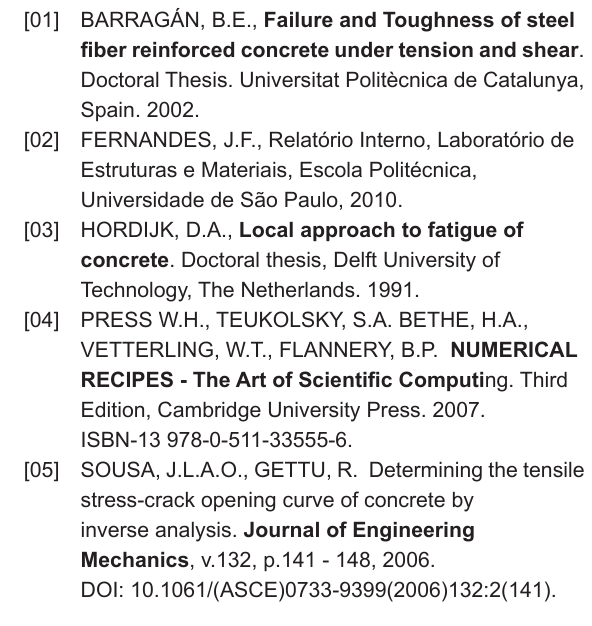
Figure 2 – Application of the implemented algorithm to three-point-bend data from tests on notched specimens of fiber-reinforced